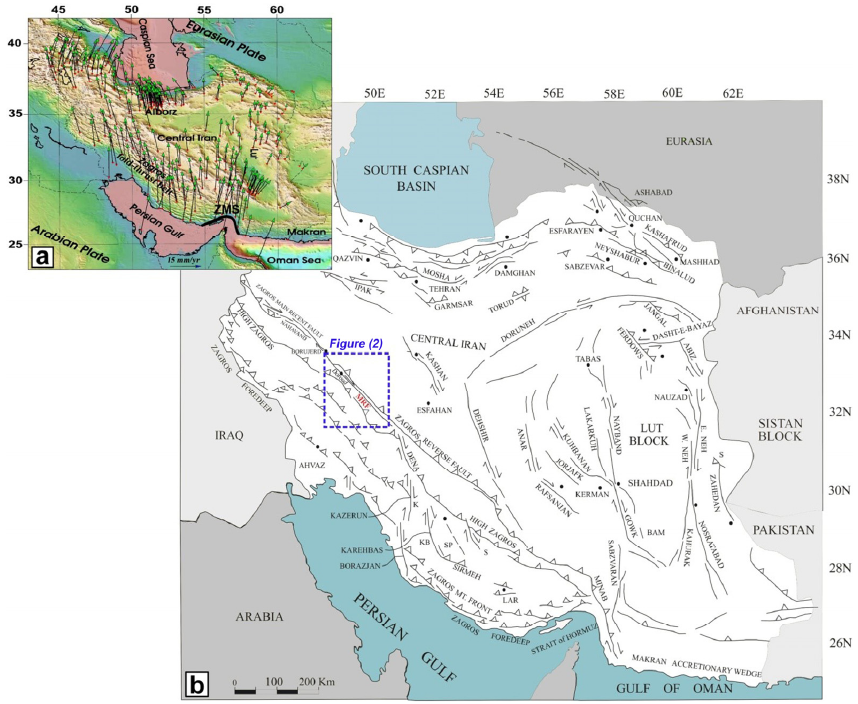
Figure 1. Map of the main active faults of Iran [14–20,24]: ( a ) The position of major Iran’s structural zones among the Arabian and Eurasian plates. AZ = Azerbaijan; KP = Kopeh Dagh; TP = Turan plate; S = Sistan suture zone; M = Makran; arrows are GPS vectors. ( b ) Distribution of active faults throughout Iran. Zagros Main Recent Fault and Zagros Reverse Fault separate the Zagros moun- tain range from central Iran. The blue frame shows the location of the study area. Doroud Fault, as one of the main segments of the Main Recent Fault, is located in the study area. KB = Karehbas Fault; S = Sarvestan Fault; SP = SabzPushan Fault.